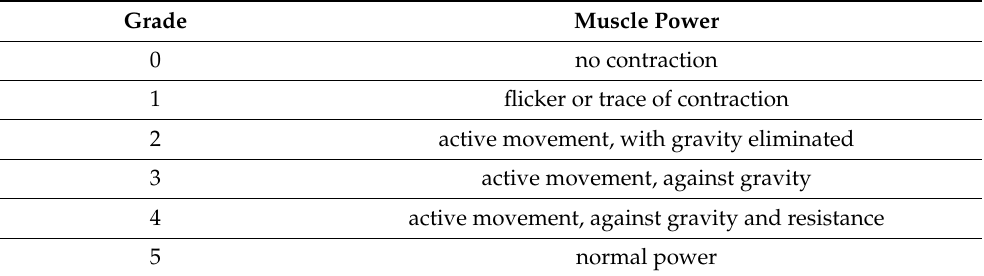
Figure 2. Patient No. 6. Intraoperative picture after nerve exploration and open reduction with internal fixation (ORIF). Intraoperative electrostimulation confirmed the preserved radial nerve continuity. Table 2. British Medical Research Council muscle power scale [12].